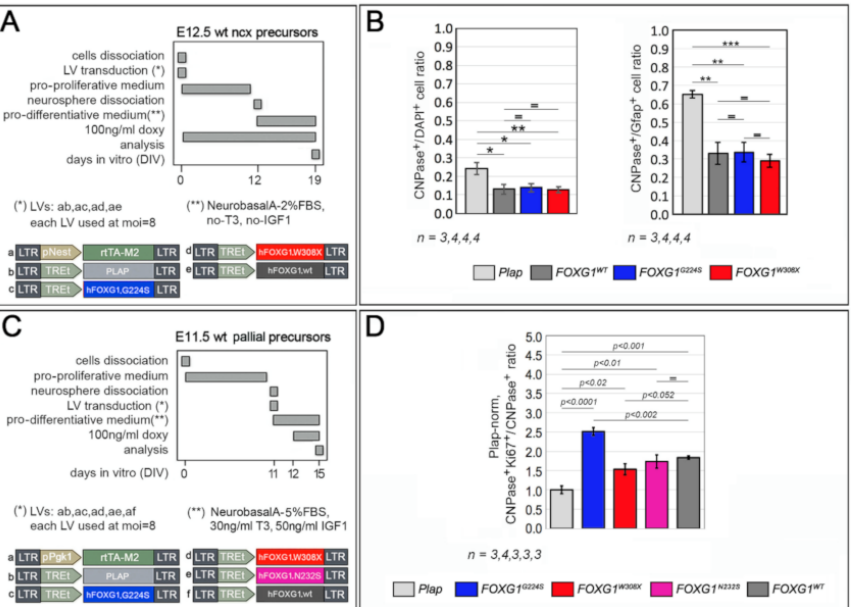
Figure 8. Impact of mutant FOXG1 alleles on oligodendrogliogenesis. ( A , B ) Frequency of astroglial GFAP + and oligodendroglial CNPase + cells, and their ratio, among derivatives of early pallial precursors, acutely transduced with Tet ON -controlled lentiviral FOXG1 transgenes, allowed to age in pro-proliferative conditions beyond the neuronogenic window, and finally allowed to differentiate. In ( A ) protocols and lentiviral vectors employed, in ( B ) results. ( C , D ) Impact of different FOXG1 alleles on mitogenic properties of oligodendrocyte-committed progenitors, upon their lentiviral transduction with transgenes encoding for such alleles, as assessed by means of Ki67/CNPase-immunofluorescence. In ( C ), protocol and lentiviral vectors employed, in ( D ), results. Shown are frequencies of intermitotic Ki67 + cells among CNPase + ones. Data normalized against Plap -expressing controls (absolute, control Ki67 + CNPase + /CNPase + ratio = 0.100). Throughout the Figure, statistical significance of results evaluated by t -test (1-tail, unpaired). * p < 0.05, ** p < 0.01, *** p < 0.001, =, not significant. n is